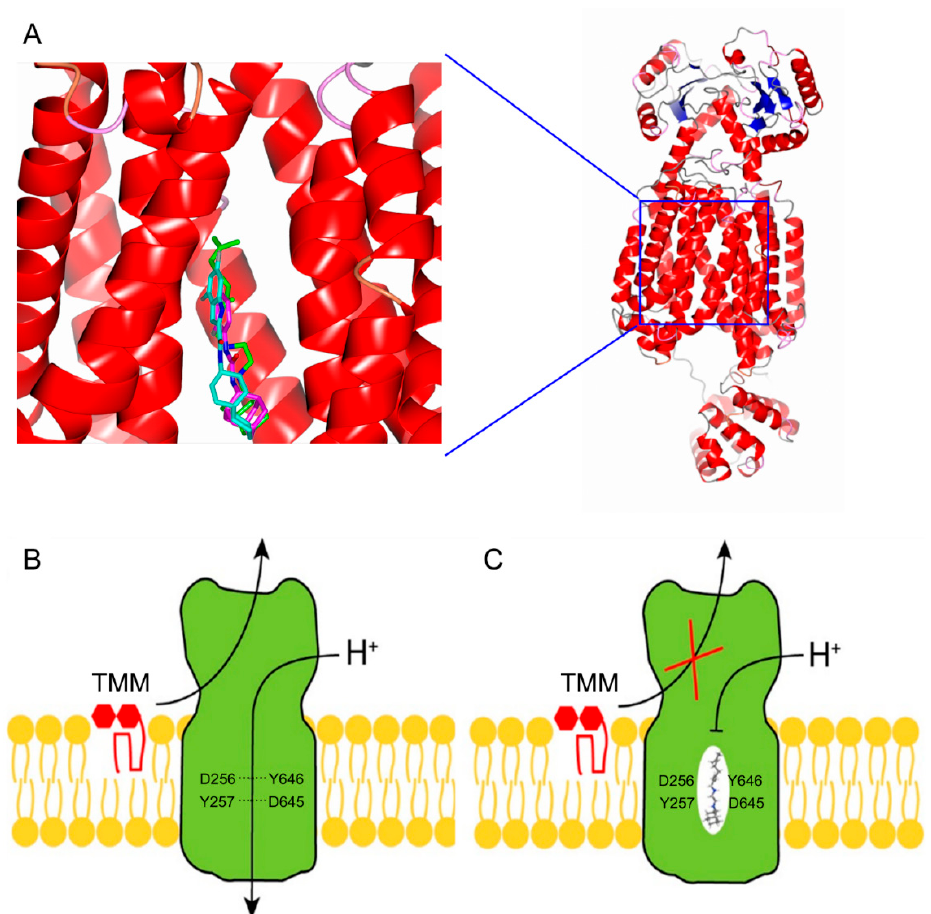
Figure 3. ( A ) Crystal structure of Mtb MmpL3 and detail of the inhibitors binding site (SQ109, PDB: 6AJG with carbon atoms in green; AU1235, PDB: 6AJH with carbon atoms in magenta; ICA38 PDB: 6AJJ with carbon atoms in cyan [25]). ( B ) Mechanism of transport of MmpL3: The flow of protons through charged residues in the transmembrane region of MmpL3 drives conformational changes that lead to the transport of TMM from the membrane to the periplasmic space. ( C ) MmpL3 inhibitors bind to a pocket in the transmembrane region of MmpL3, disrupting the electrostatic interactions between D256 and Y257 with Y646 and D645, respectively. This blocks the proton relay pathway and ultimately TMM translocation.